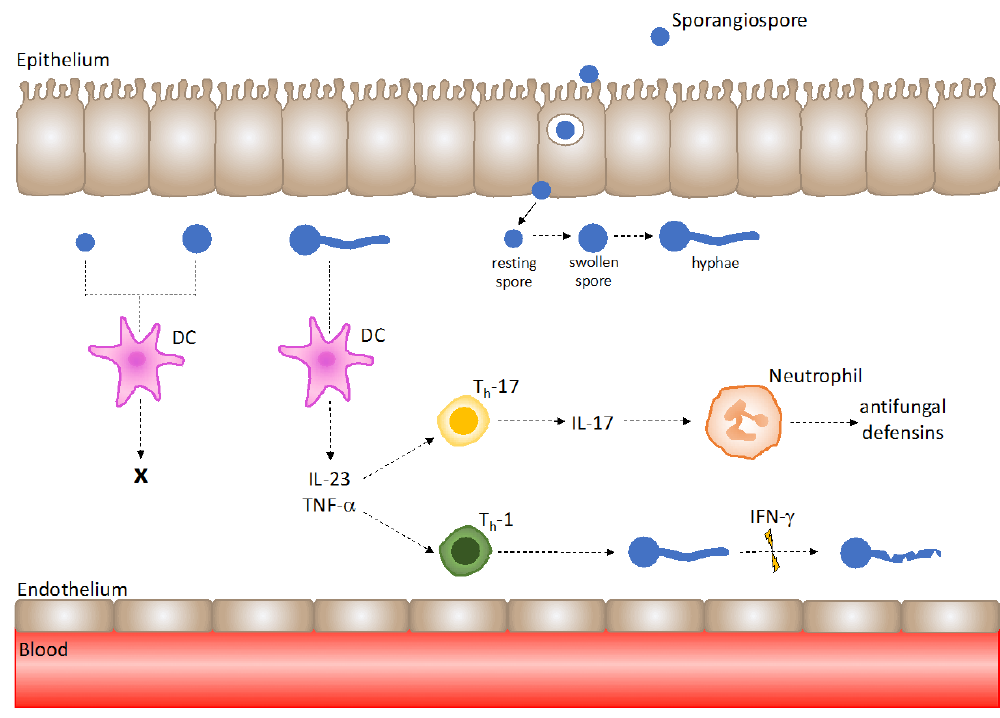
Figure 2. Mucorales hyphae are recognised by dendritic cells (DCs) to trigger T-helper cell responses under healthy host immunity. DCs are not activated by Mucorales spores; however, exposure to hyphae results in DC activation and the robust release of IL-23 and TNF- α . IL-23 promotes T h -17 responses, and TNF- α upregulates T h -1 responses. IL-17 production by T h -17 cells aids neutrophil recruitment and antifungal defensin release, and IFN- γ secretion by T h -1 cells exhibits Mucorales hyphal